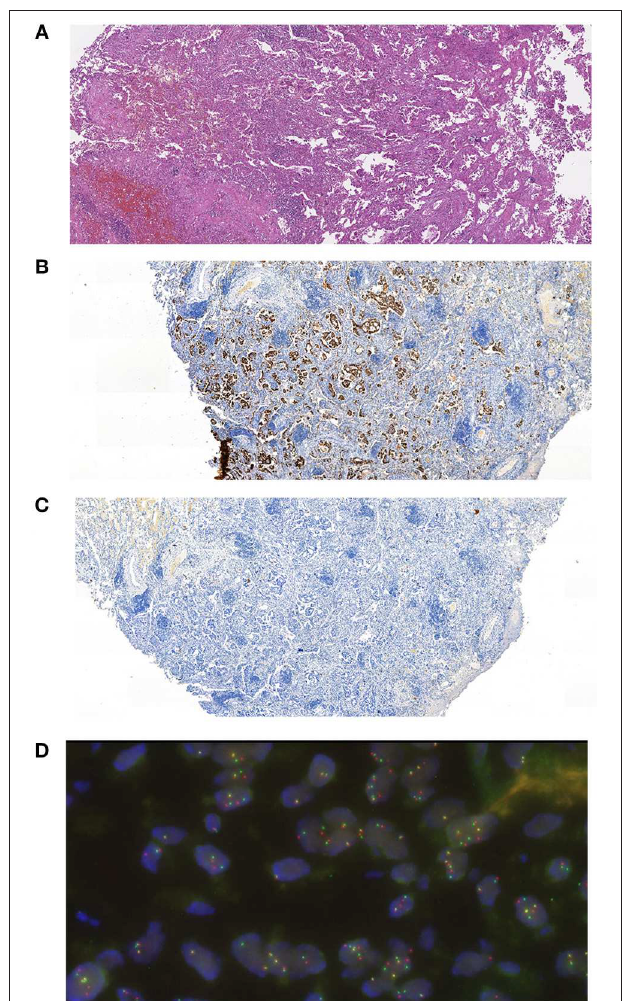
FIGURE 1 | Histological evaluation of the patent’s tumor. (A) Hematoxylin and eosin staining microphotograph. (B) Immunohistochemical staining for TTF-1 (SPT24). (C) Immunohistochemical staining for p40 (DeltaNp63). (D) FISH analysis for ALK-EML4